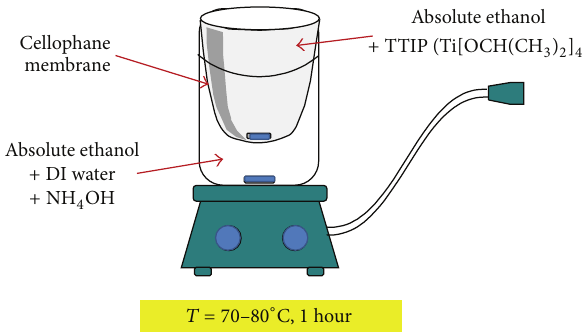
Figure 1: Scheme of the modified sol-gel method